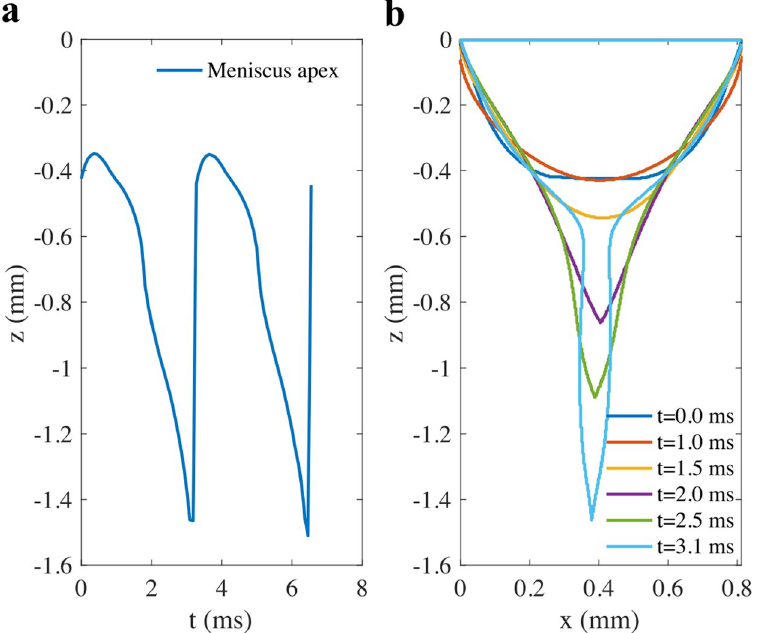
Figure 8. Image processing of meniscus contour. ( a ) Meniscus apex location as a function of time of electrospray operating in microdripping mode (Si, 5 wt% in H 2 O, H 1 = 4 mm, φ o = 4000 V). Two periods are shown which consist in the formation of two monodisperse microdroplets at t = 3.1 ms and t = 6.4 ms. ( b ) Sequence of the meniscus contour of microdripping mode corresponding to case used in ( a